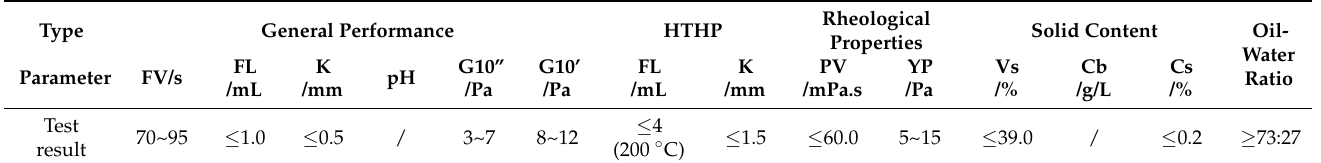
Table 6. Optimized performance parameters of the modified starch polyamine anti-collapse water- based drilling fluid tested on the wellsite.